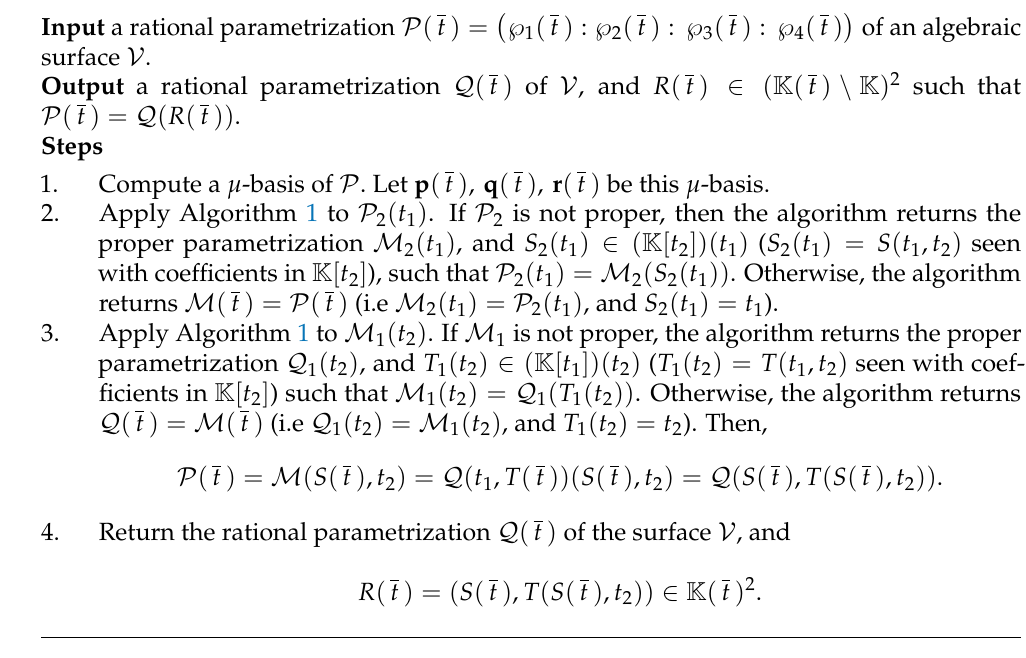
Algorithm 2 Proper Reparametrization for Surfaces using µ